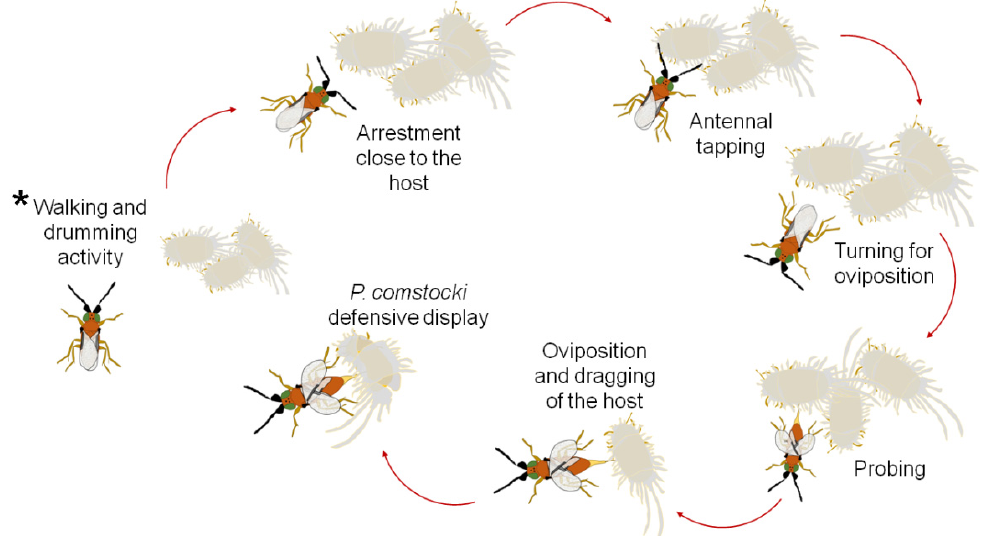
Figure 1. Host searching and parasitization behavior of Anagyrus vladimiri towards Pseudococcus comstocki (the asterisk indicates where the behavioral sequence begins).